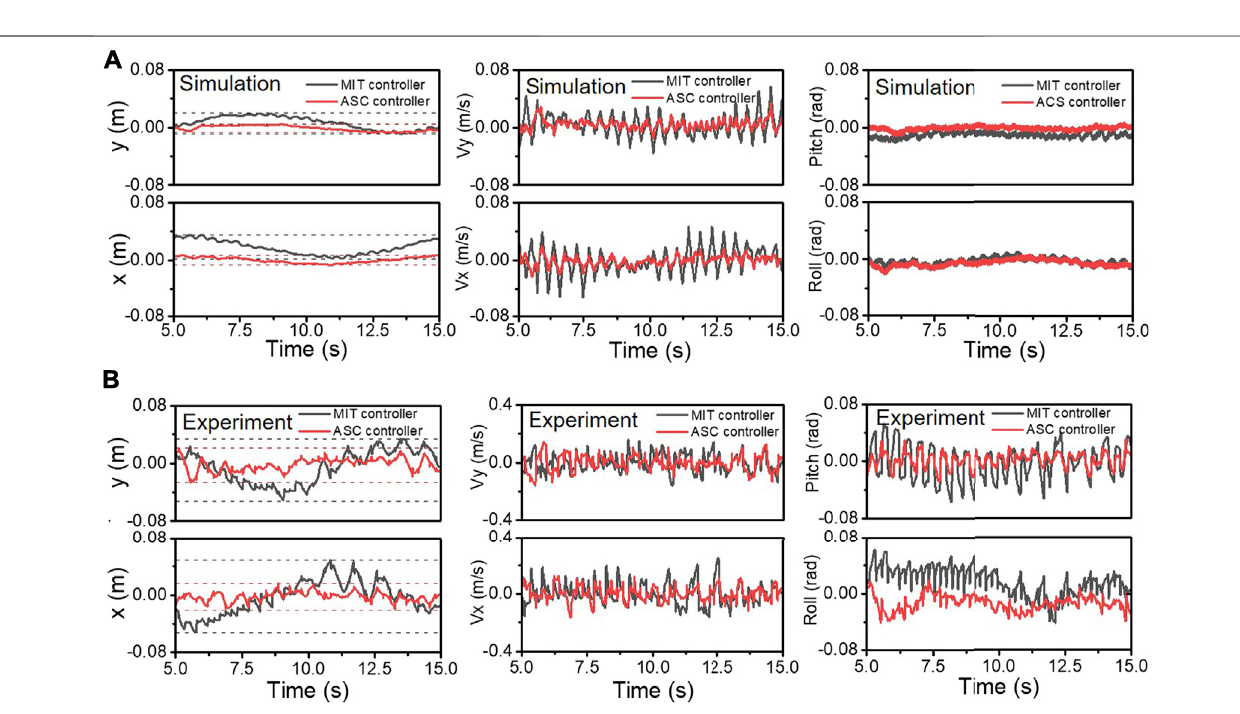
Frontiers in Robotics and AI |